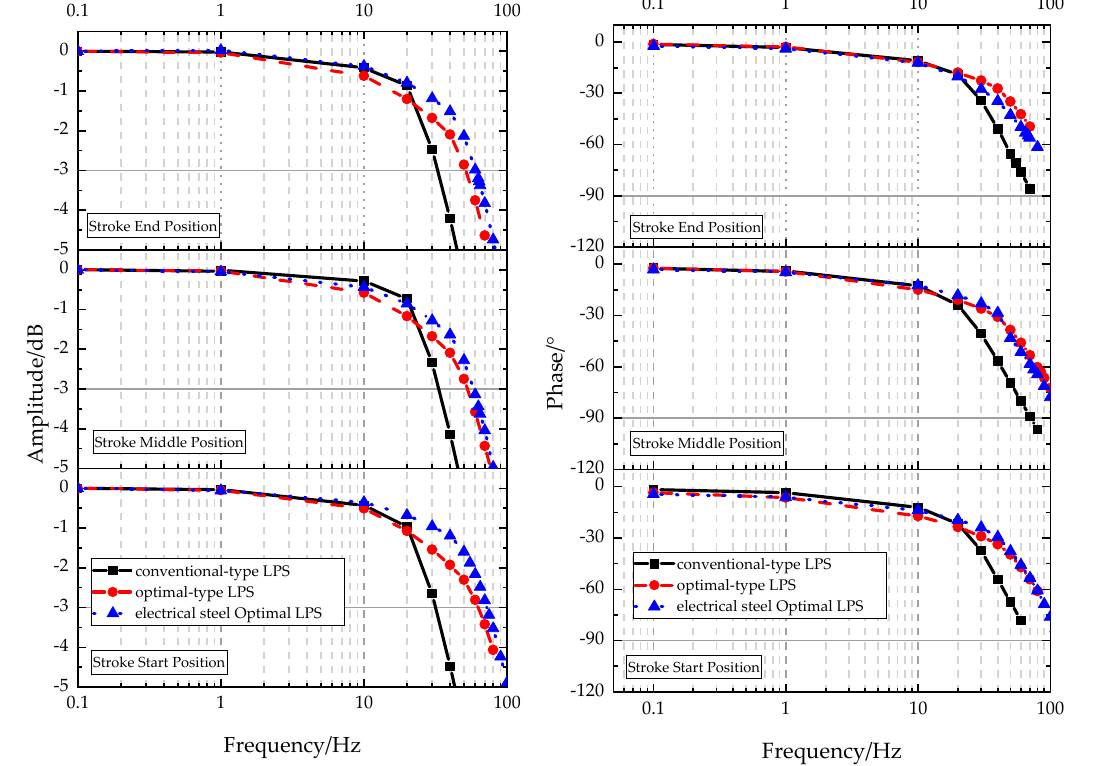
Figure 14. Frequency response of the push force at fixed air gap.